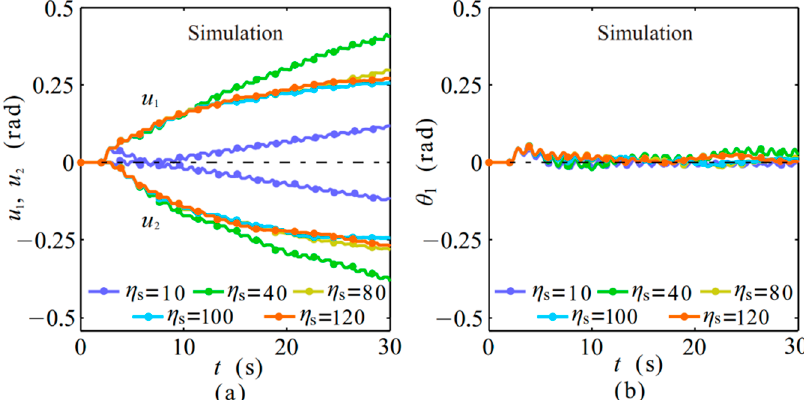
15 of 20 Figure 13. Serial-stiffness-switch system experiment results for harmonic disturbances under differ- ent disturbance torque amplitudes 𝑀(cid:3553) (cid:2914) , here 𝜂 (cid:2929) = 100 and 𝜂 (cid:2914) = 3 . ( a ) Deformations of the two springs, 𝑢 (cid:2869) and 𝑢 (cid:2870) ; ( b ) displacement of the primary plate, 𝜃 (cid:2869) . As mentioned previously, the sampling period T s determines the switching delay, which strongly influences the switching decision error and further influences the switch- ing system performance. Thus, Figures 14 and 15 show the simulation and experiment results for harmonic disturbances with different dimensionless sampling frequencies. They show that an overly low sampling period, for instance 𝜂 (cid:2929) = 10 , lowered the energy conversion power and did not reduce vibrations, because the high sampling period in- creased the switching determination error. With an increasing dimensionless sampling frequency, the energy conversion power initially increased. When the sampling period was large enough and energy had been converted, the vibration reduction lowered the